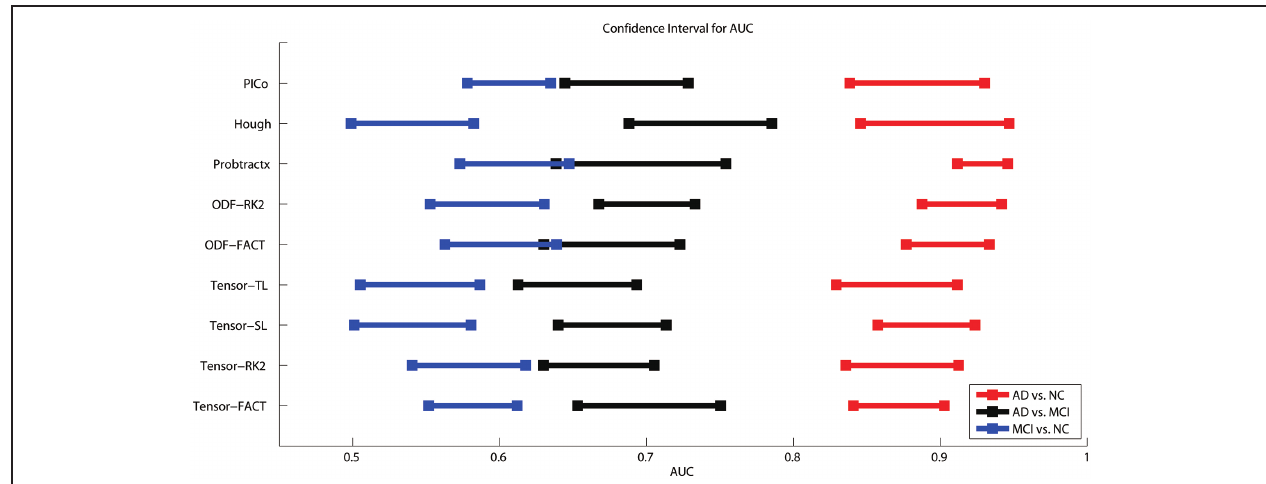
FIGURE 3 | Ninety five percent confidence intervals (CI) for the AUC (classification accuracy) for three diagnostic tasks represented by the three color bars (blue, black, and red) for nine tractography algorithms. The red color means the AD vs. NC classification task, black colors denote AD vs. MCI, and blue colors indicate MCI vs. NC. The y-axis indicates the tractography algorithms and x-axis shows the AUC value. In